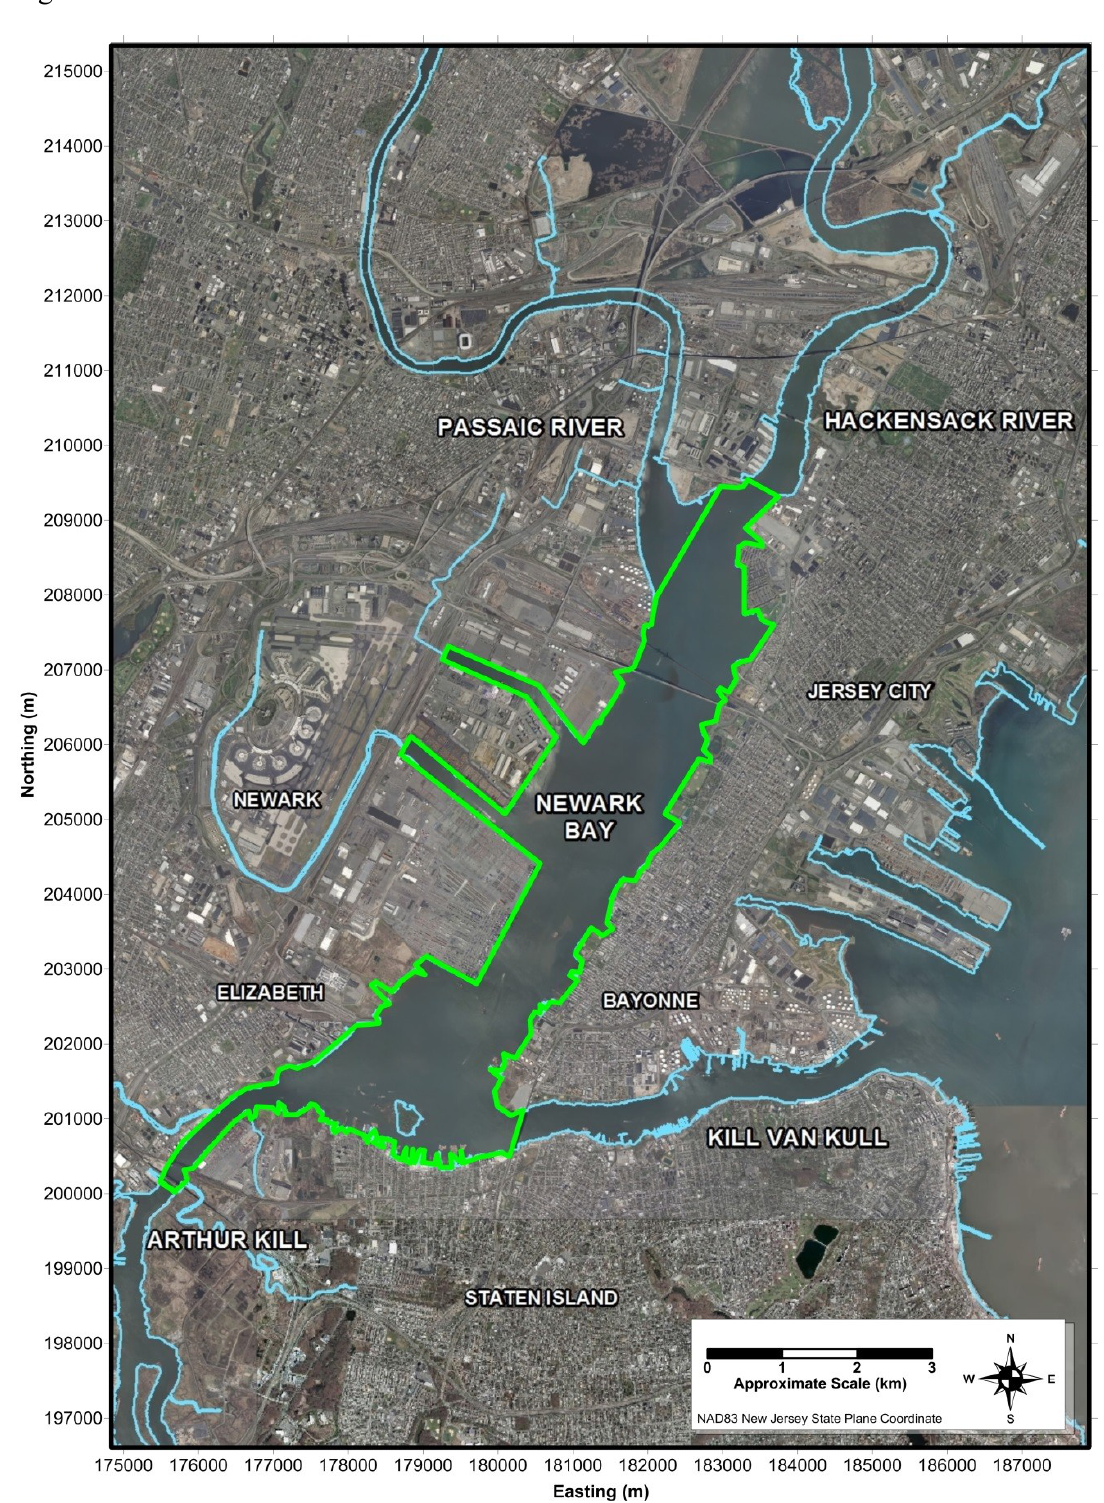
Figure 1. Regional map of Newark Bay and the Newark Bay Study Area (NBSA) outlined in